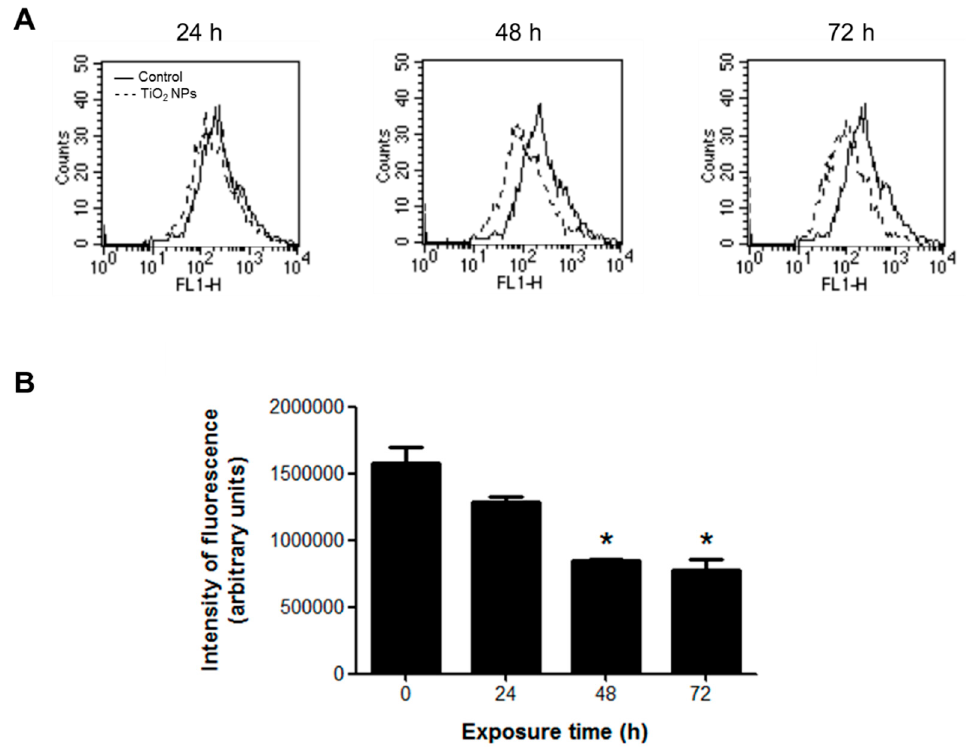
Figure 4. TiO 2 NPs decreased ΔΨ m in H9c2 cells treated with 20 μ g/cm 2 TiO 2 NPs for 24, 48, and 72 h. ΔΨ m changes were measured by the fluorescent dye Rh123 in a flow cytometer. ( A ) Histograms of